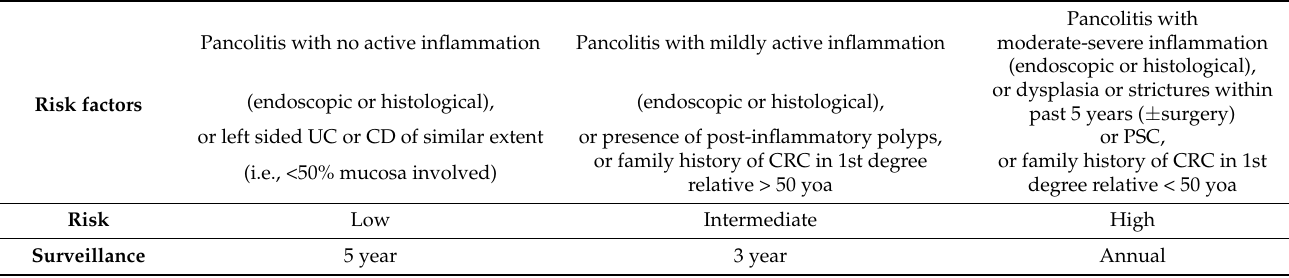
Pancolitis with moderate-severe inflammation (endoscopic or histological),